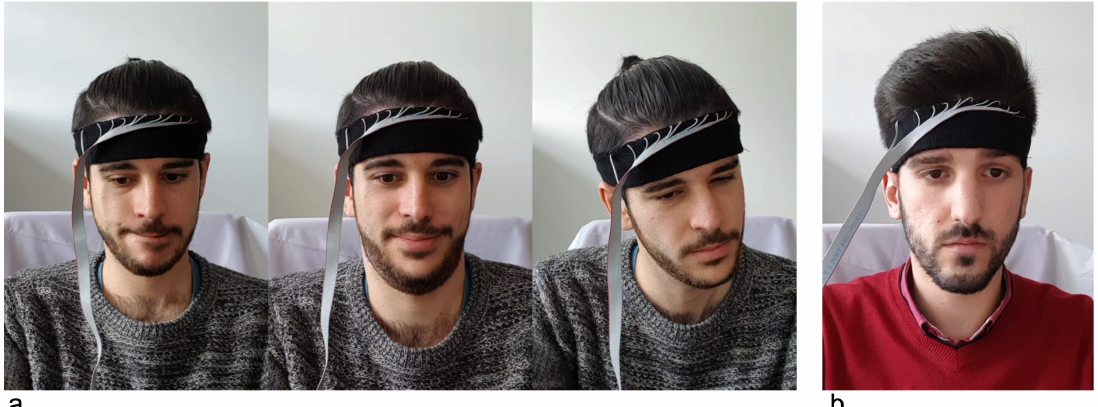
Figure 9. ( a ) Participant 1 has very vivid and active expressions under cognitive challenges. ( b